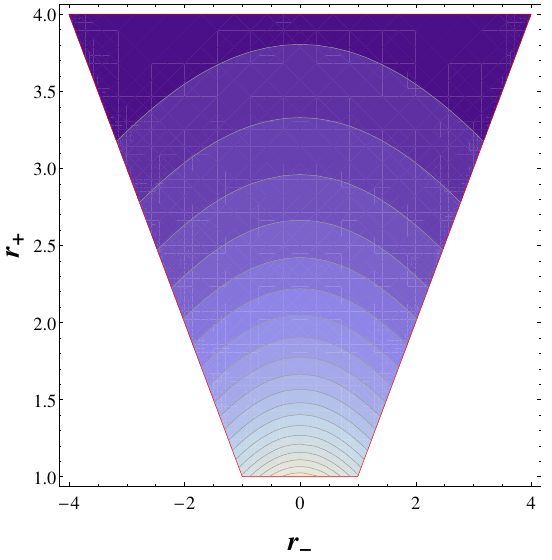
Figure 1 . Numerical plot of level curves of (cid:21) 0 as functions of r + and r (cid:0)